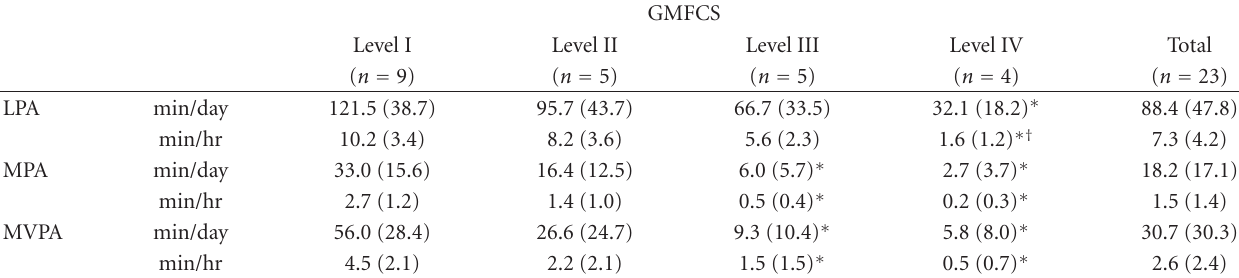
Table 1: Minutes of activity per hour and per day of monitoring time.